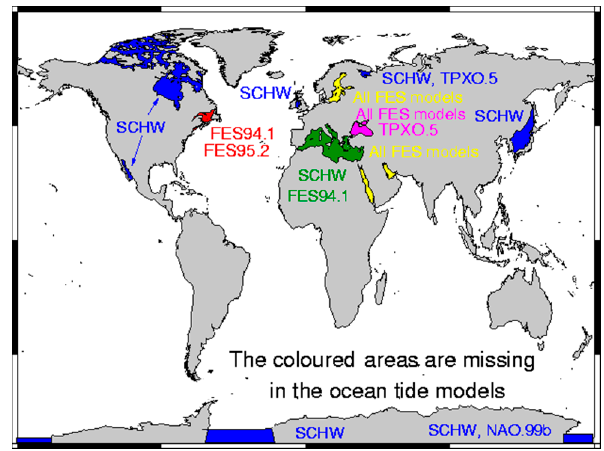
Figure 5. Map of areas where ocean tide patterns are missing, taken from [45].